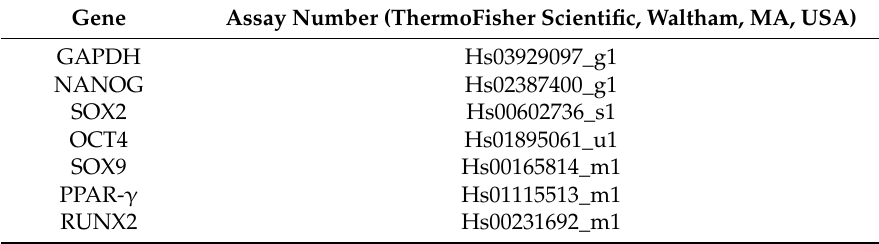
Table 2. TaqMan ® gene expression